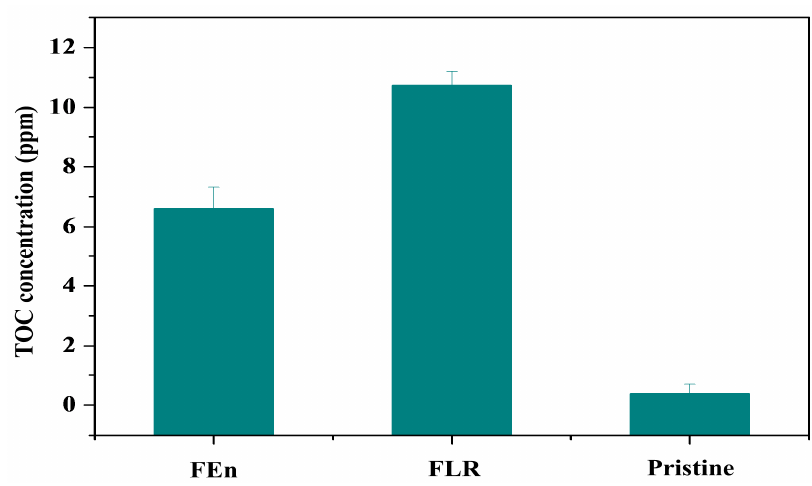
Figure 14. Total organic carbon (TOC) concentration of the eluted organics from the foulants on the membrane surface.